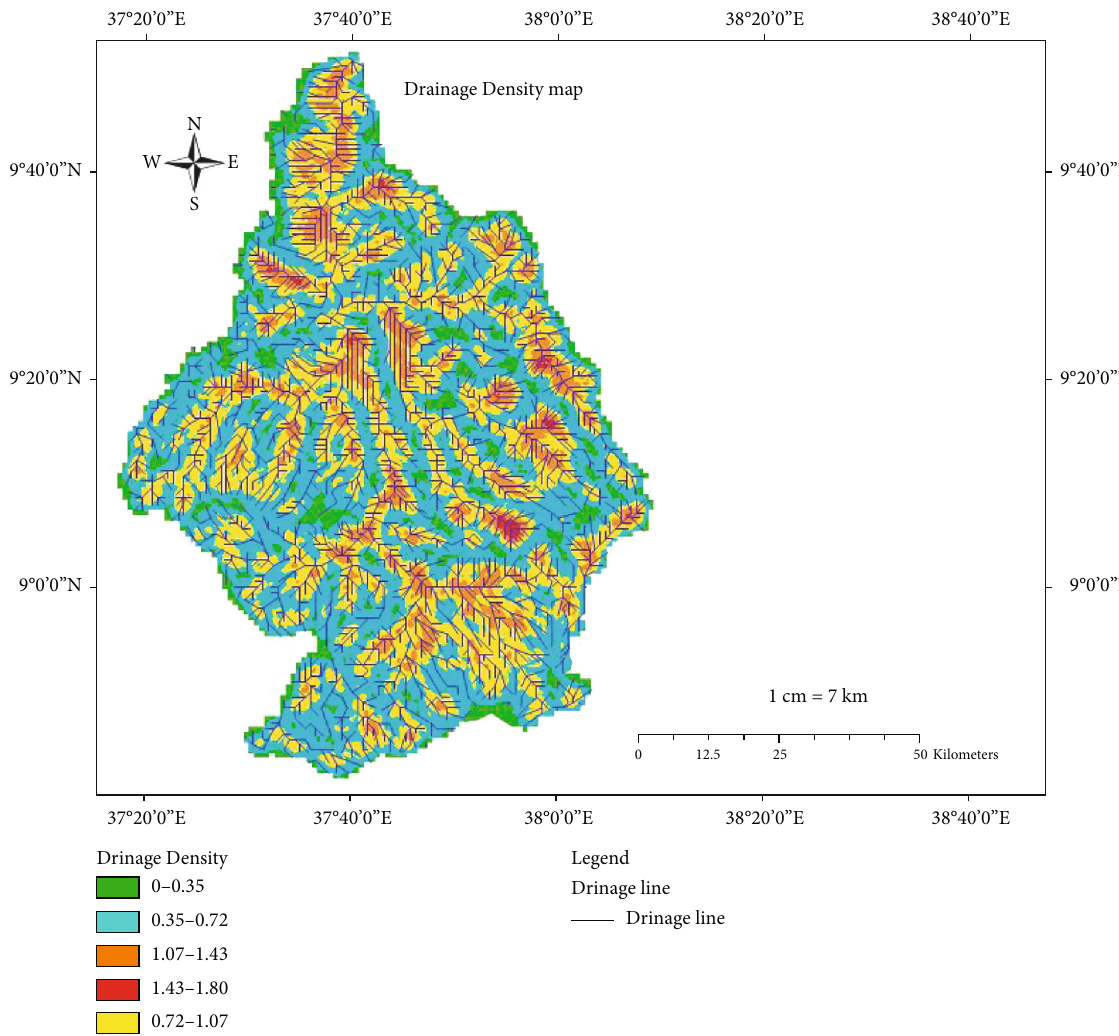
Figure 12: Drainage density map of the study